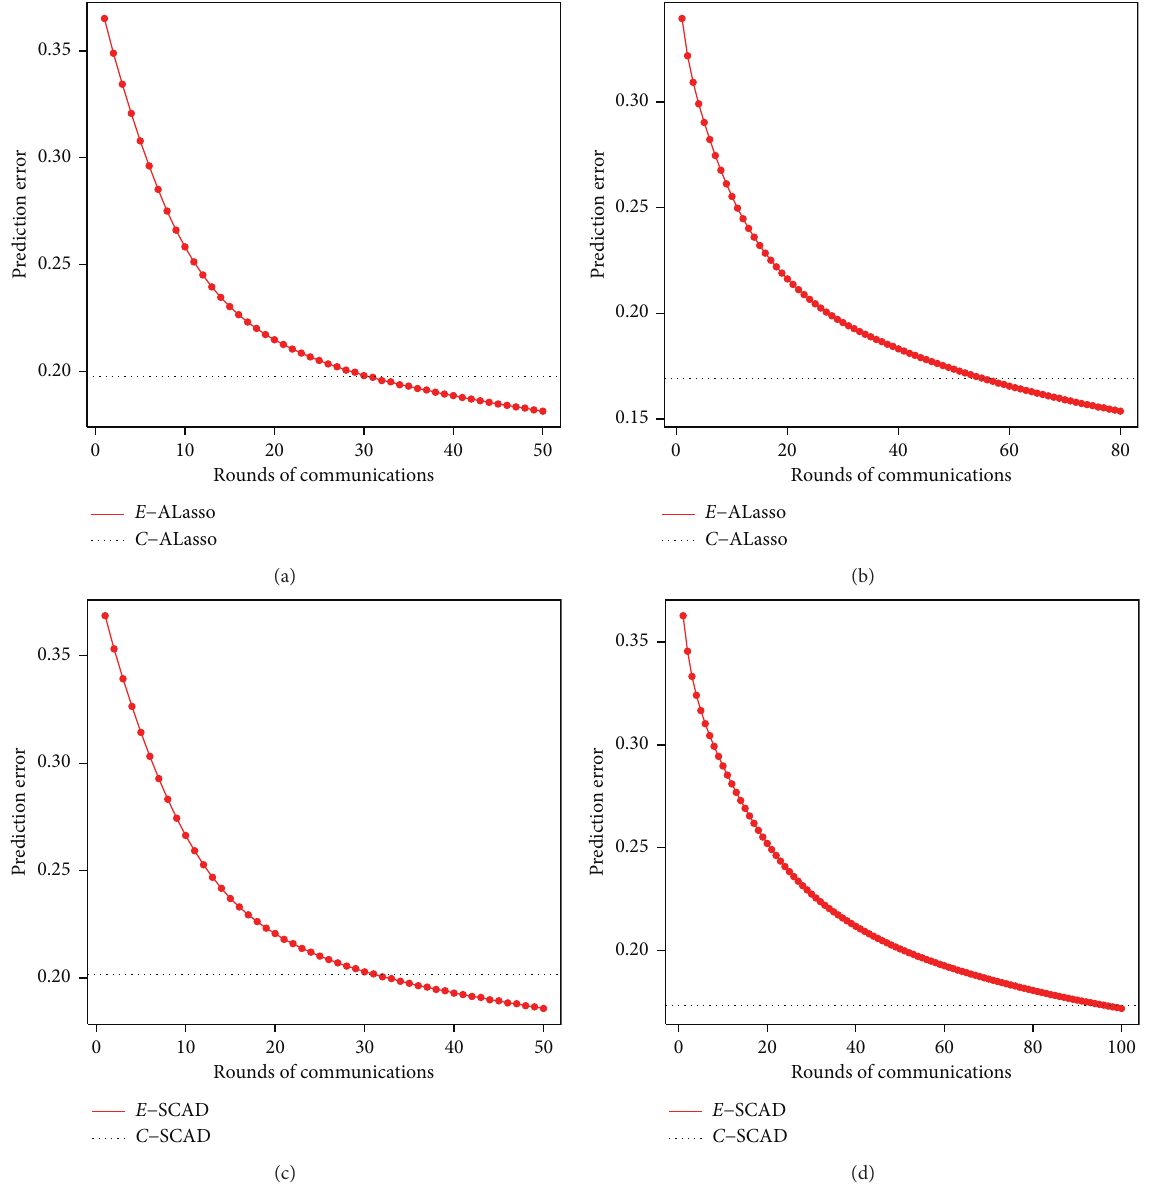
Figure 2: Comparison of two methods for the prediction error with the HIV data. (a) ALasso , τ � 0 . 5. (b) ALasso , τ � 0 . 75. (c) Scad , τ � 0 . 5. (d) Scad , τ � 0 .